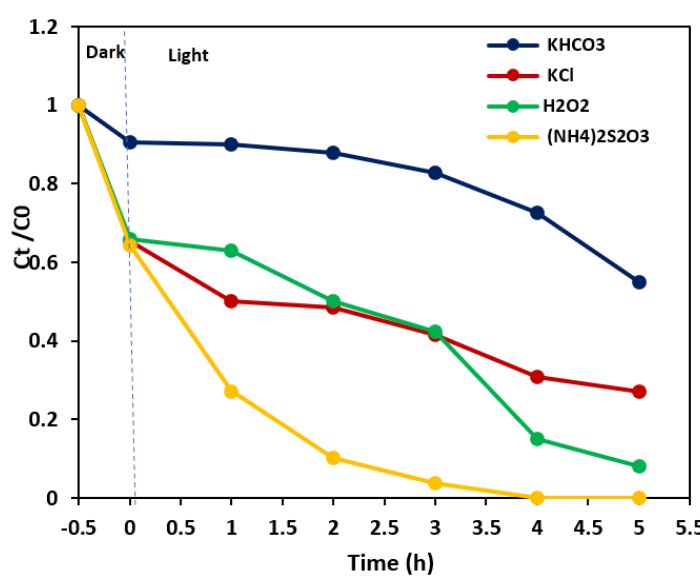
Figure 6. Effect of acceptor reagents on DR16 dye removal.